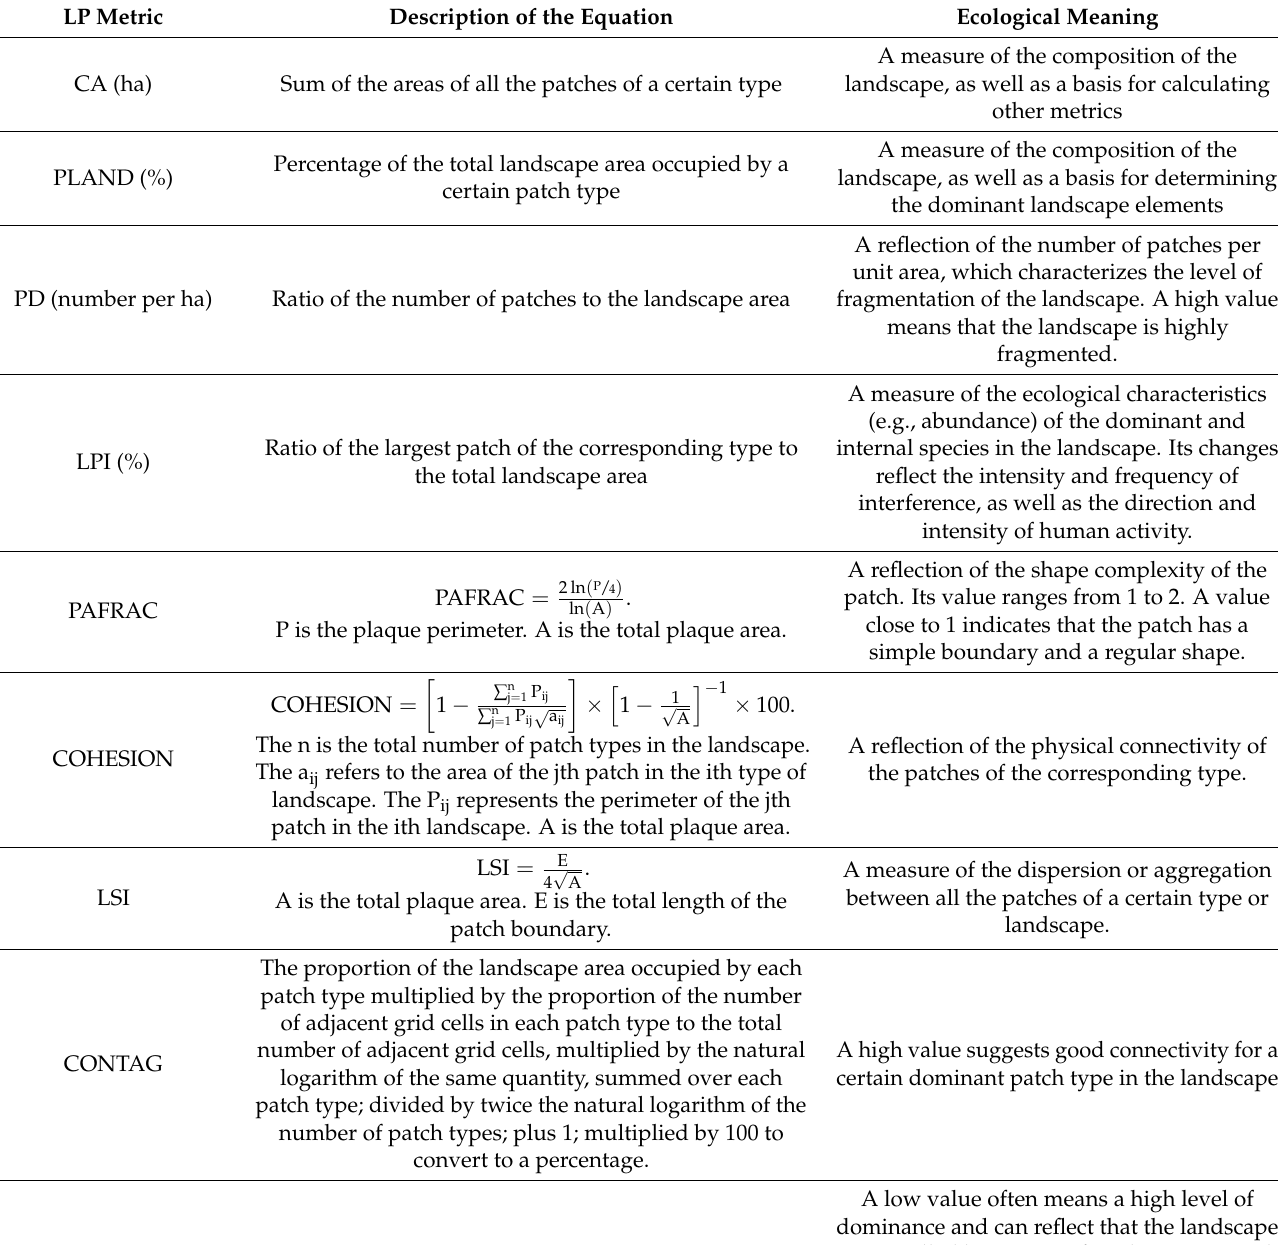
Table 1. Brief explanation of the landscape pattern